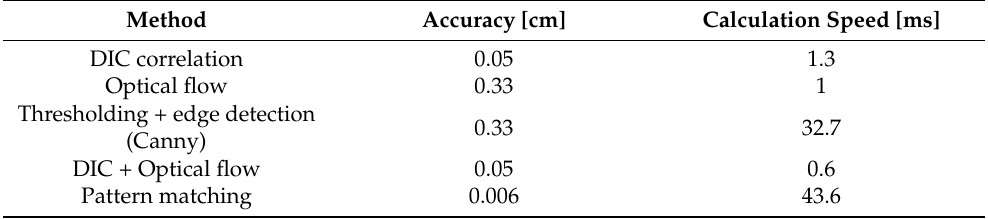
Table 1. Comparison of results.